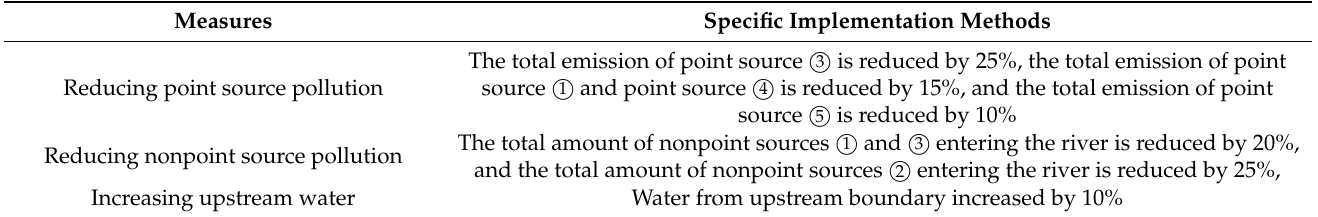
Table 5. Setting of water pollution control